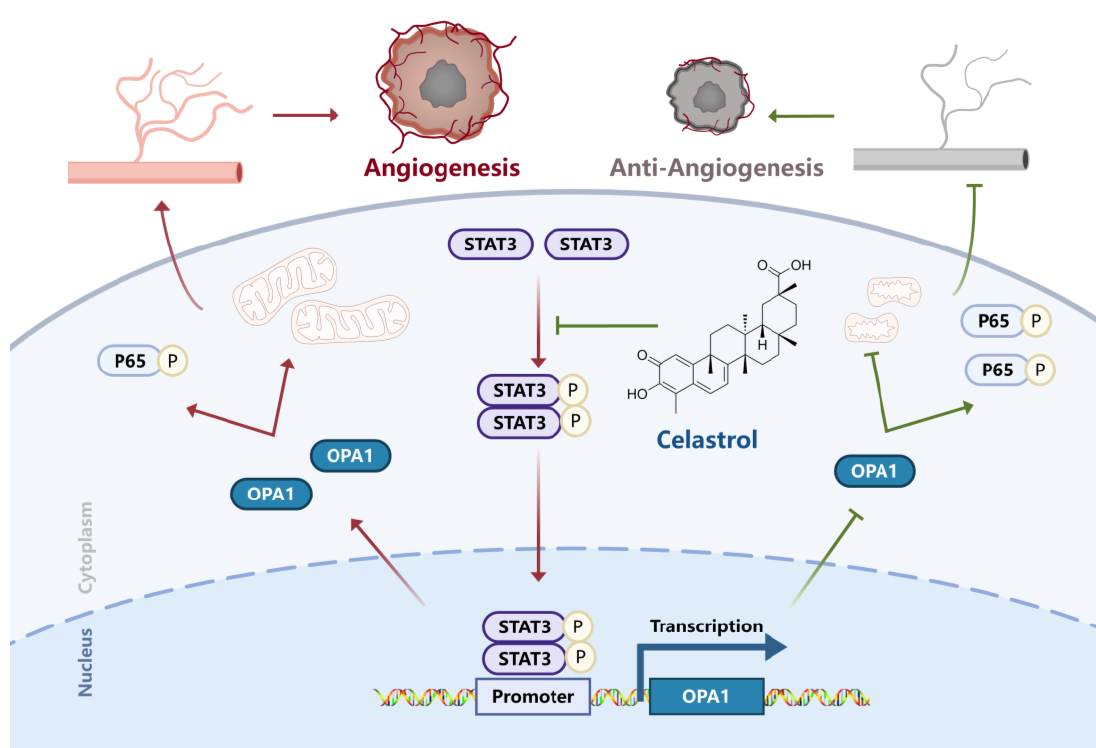
Figure 6. Schematic representation of celastrol inhibiting angiogenesis.